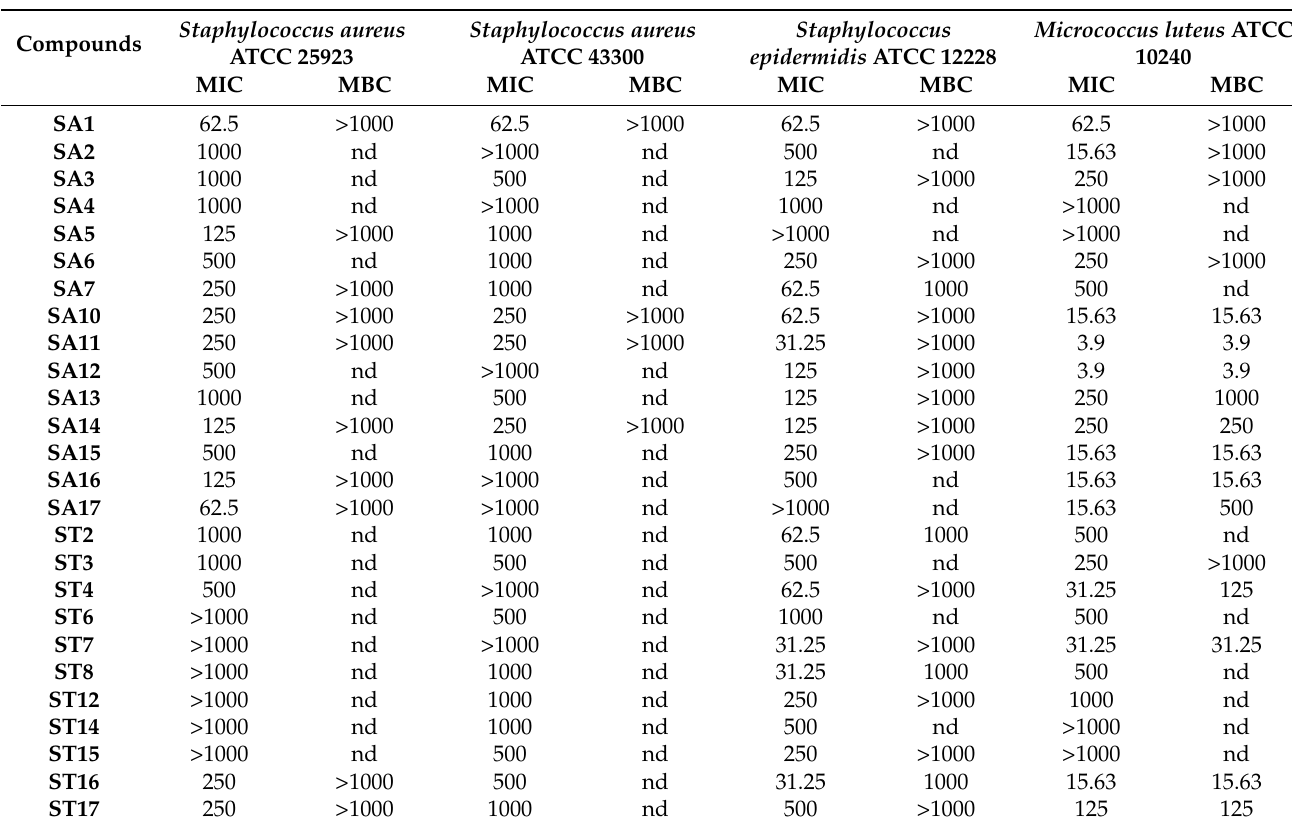
Table 1. Antibacterial data (MIC and MBC, µ g/mL) for thiosemicarbazide SA1 - SA18 and 1,3,4- thiadiazole ST1 - ST18 derivatives and reference